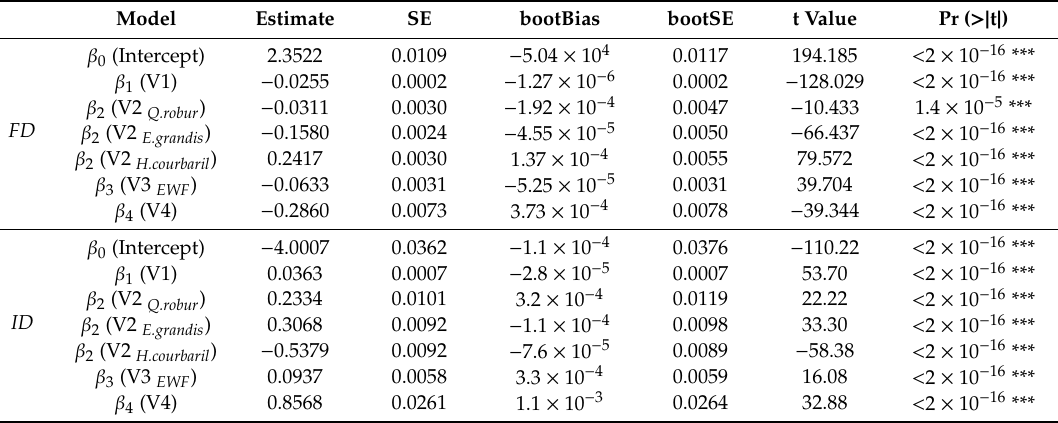
Table 10. The estimates of Generalized Linear Model (GLM) for footprint diameter (FD)and indentation depth (ID) with bootstrap